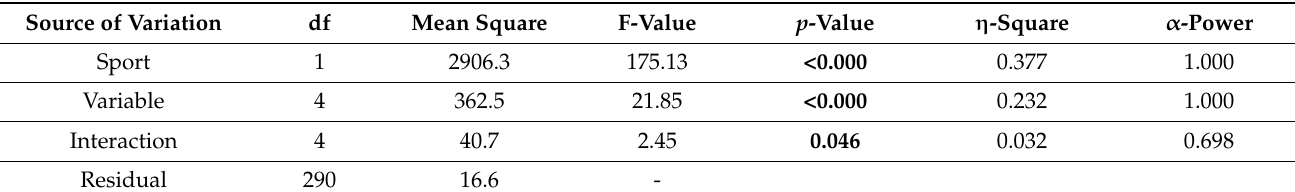
Table 3. Detailed results of ANOVA